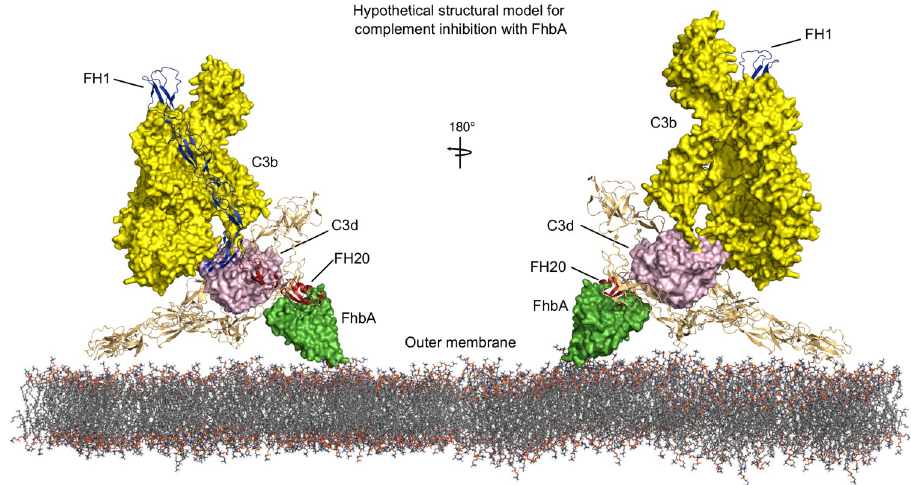
Fig 6. A working model for how BhFhbA recruits FH to mediate immune evasion. Membrane-bound BhFhbA (bright green) recruits FH (cartoon representation) of the host through binding site on domain 20 of FH (in red). When bound to BhFhbA, FH domains 1–4 are free to bind to C3b (yellow) and inhibit complement. When bound to microbial protein via domain 20, FH can also bind C3d fragment (in pink) via domain 19. Full-length FH model was manually constructed in Pymol by combining existing structures of different subcomplexes. Model for FH1-4 bound to C3b was from PDB2wii [15]. Structures of FH19-20 (in red) bound to C3d were obtained from PDB entries 5nbq [56] and 2xqw [66].